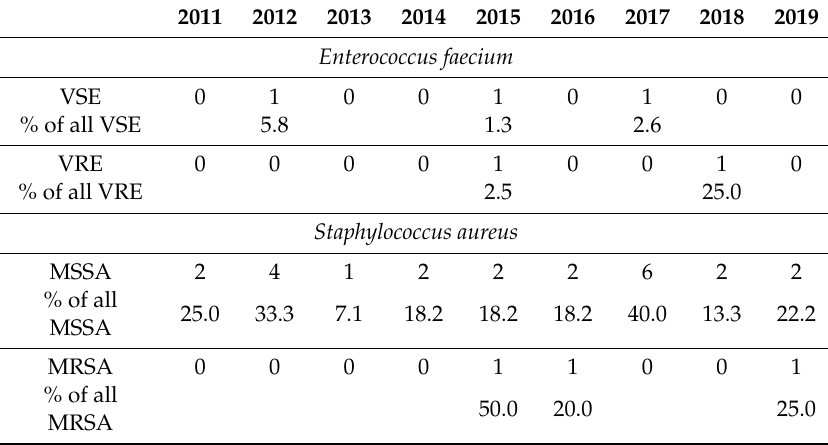
Table 3. Number of patients per year on ERWIN exhibiting vancomycin-susceptible E. faecium (VSE), vancomycin resistant E. faecium (VRE), methicillin resistant S. aureus (MRSA), and methicillin-susceptible (ESBL) and Ampicillin-susceptible E. faecium were not isolated from blood